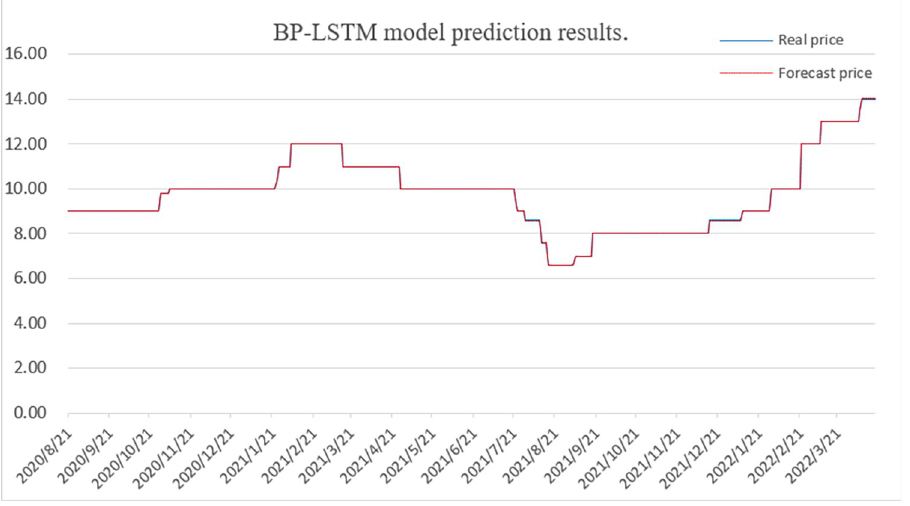
Fig 10. BP-LSTM model test set prediction